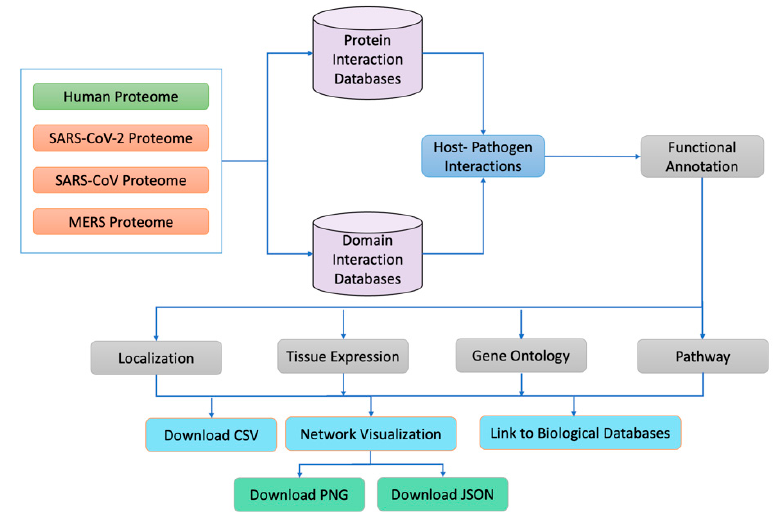
Figure 1. An overall workflow of the HuCoPIA database.